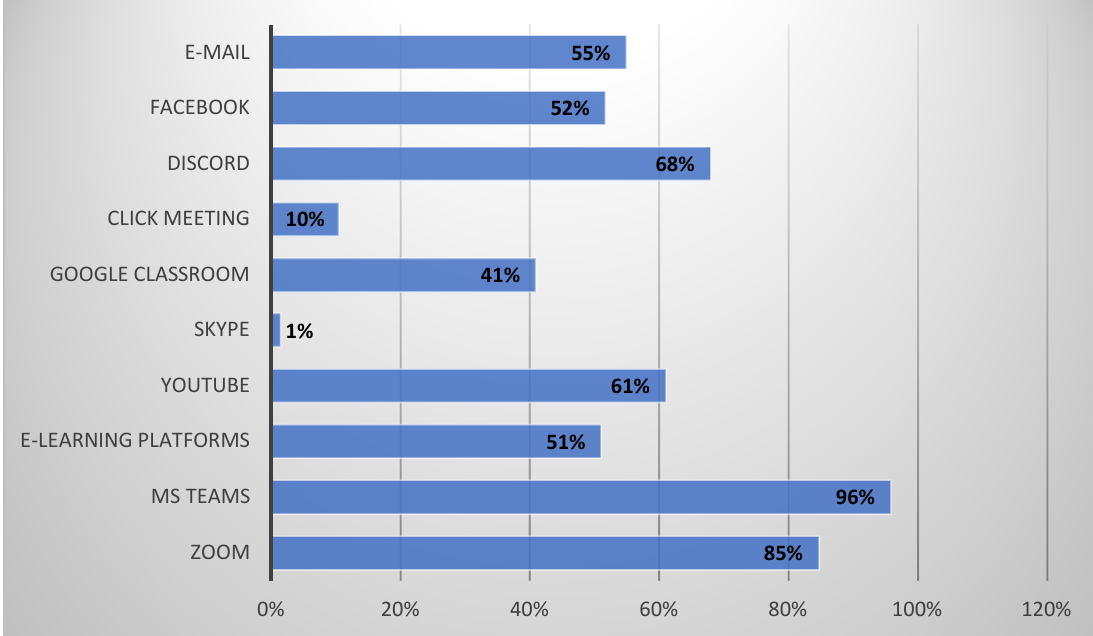
Figure 2. Percentage of students familiar with a given e-learning tool—currently.